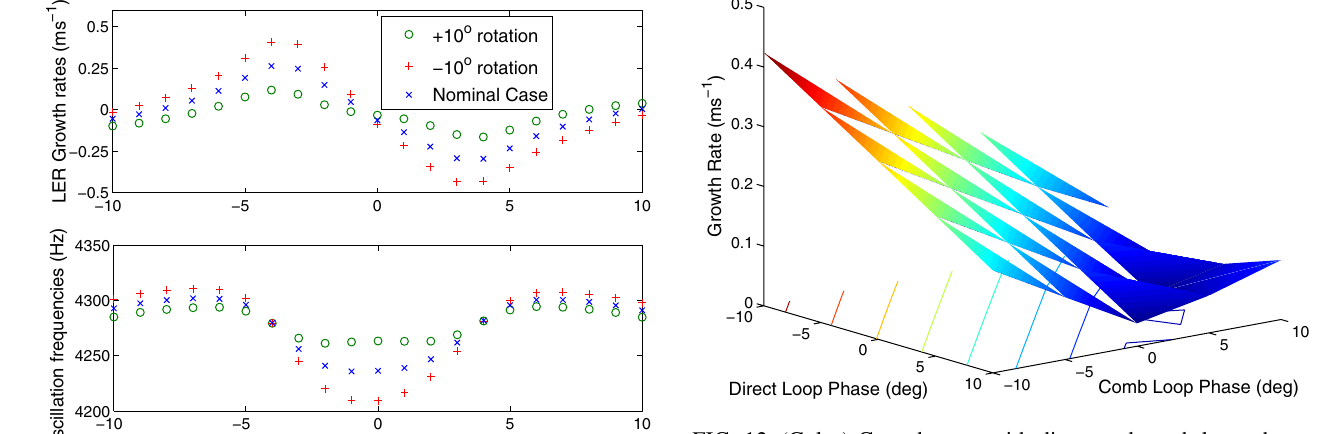
FIG. 12. (Color) Growth rates with direct and comb loop phase rotation for the LER at 1400 mA.